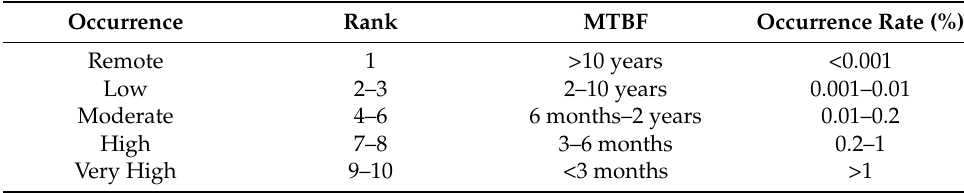
Table 4. Summary comparison between JESs and D-JESs.